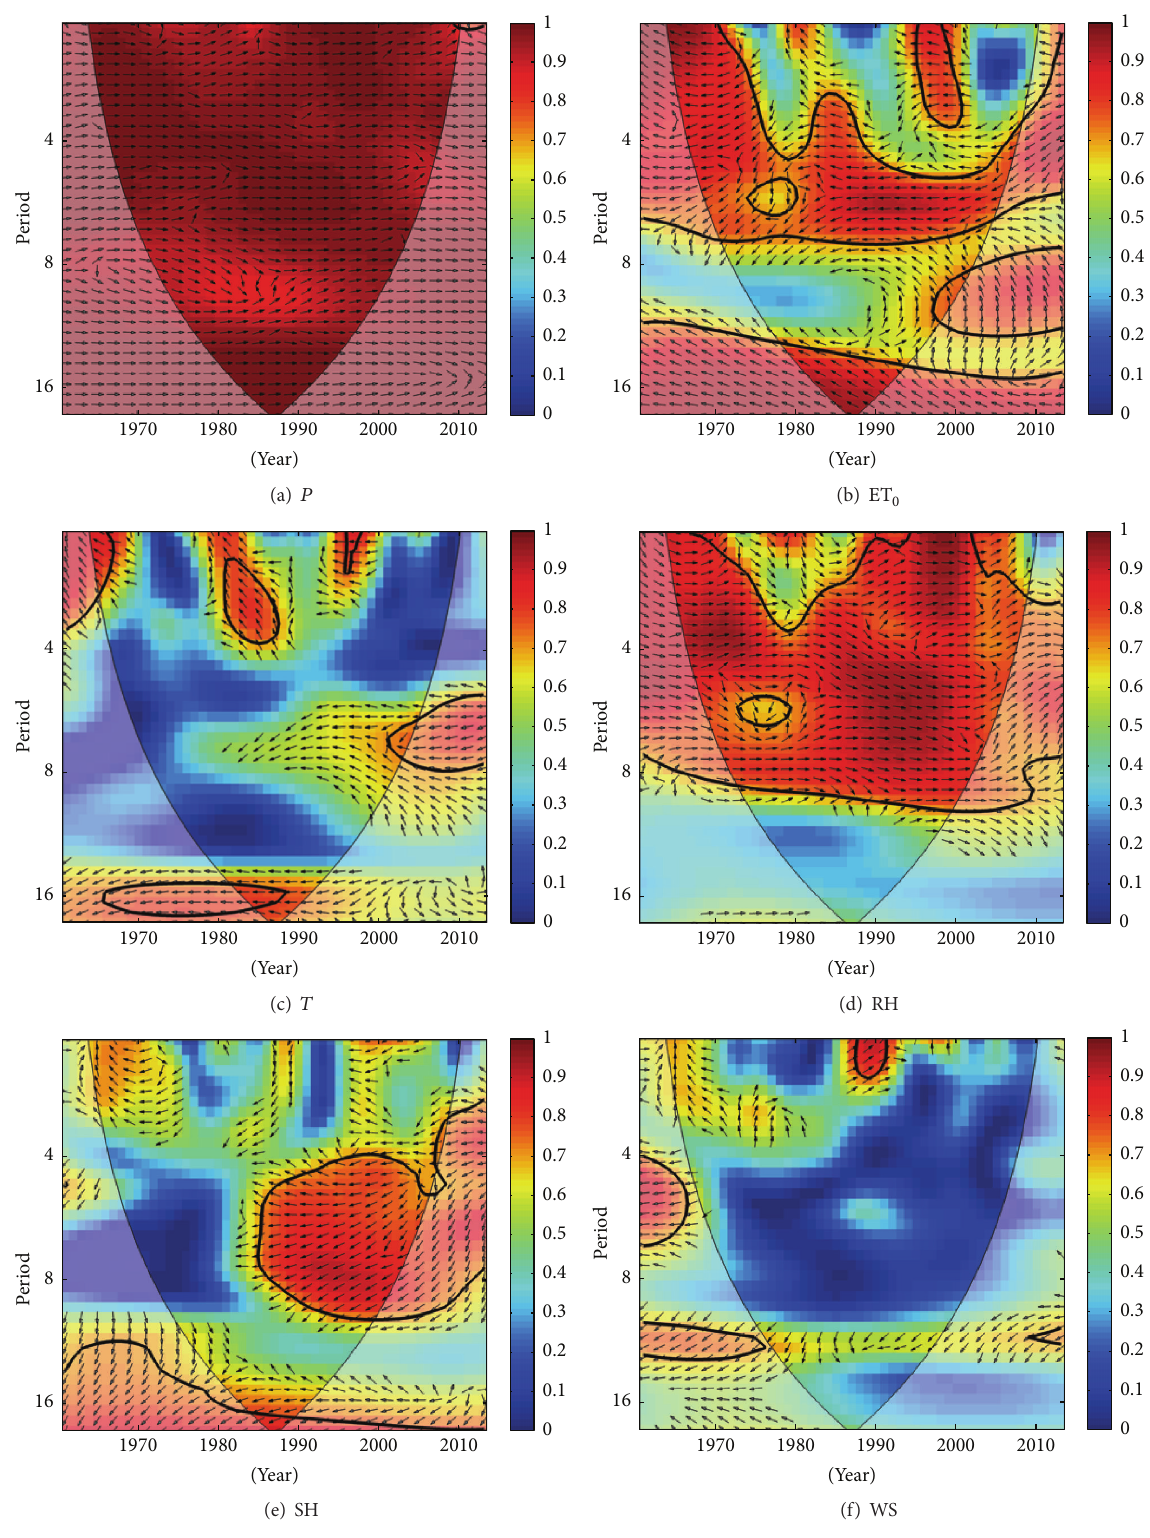
Figure 9: Wavelet coherence between annual AI and meteorological factors in North Xinjiang, China. The black contour lines show the regions of power significant at the 95% level, which are computed based on 1000 Monte Carlo simulations. The cone of influence (black curve) indicates the region without edge effects. The power values are coded from dark blue for low power to dark red for high power, as shown in the right panel on each figure. The vectors indicate the phase difference between the aridity and annual meteorological factors: → : in phase; ← : in antiphase; ↑ : 𝑋 leading 𝑌 by 90 ∘ ; ↓ : 𝑌 leading 𝑋 by 90 ∘